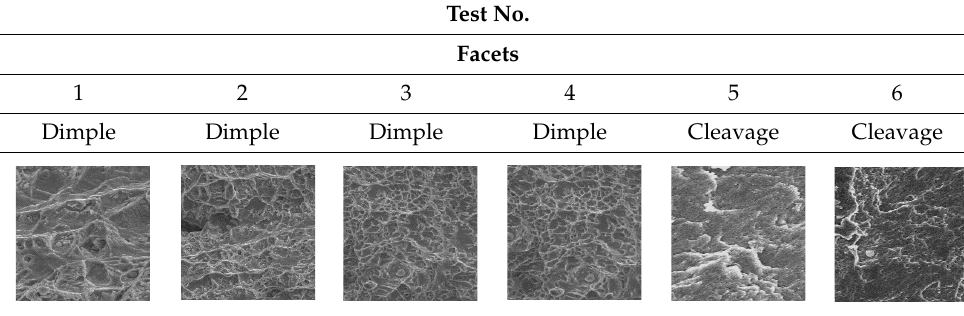
Table 7. Results of fracture geometry of the heat-affected zone according to the Charpy impact test. Test No.